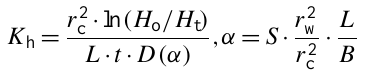
Fig. 7. Slug test results for borehole BH5 (markers represent different initial heads for slug test)